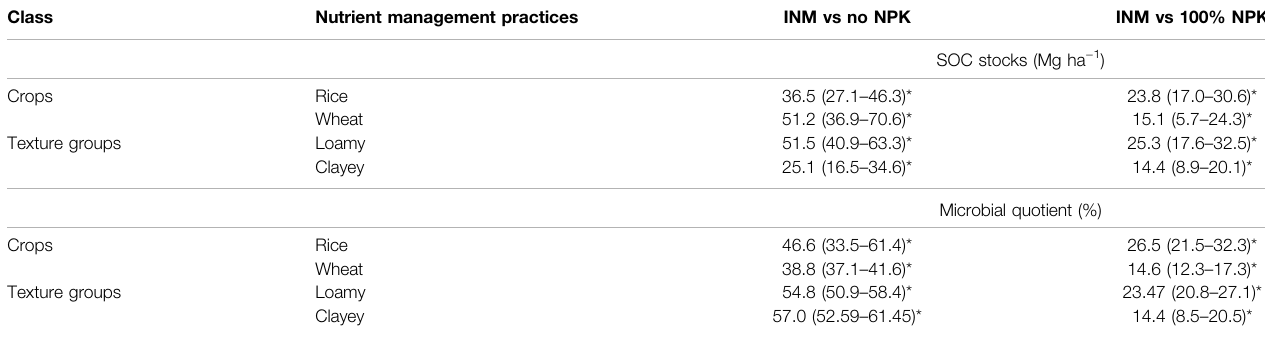
TABLE3| Effectofintegratednutrientmanagement(INM)onsoilorganiccarbon(SOC)stocksandmicrobialquotientwithrespecttowithoutNPKand100%NPKinriceand wheat crops as in fl uenced by soil texture: loamy and clayey in Indian soils.